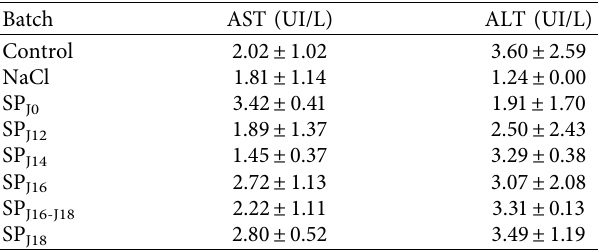
Table 2: Effect of injection of sulfadoxine-pyrimethamine com- bination on biochemical parameters (AST and ALT) of